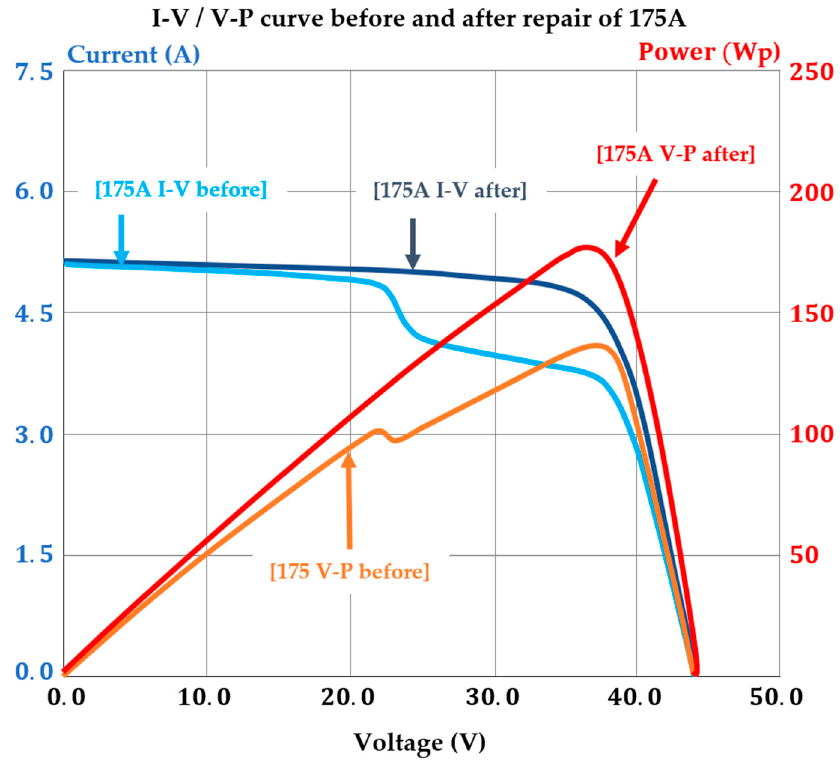
Figure 2. Characteristic curves of I-V and V-P before and after repair of 175A.